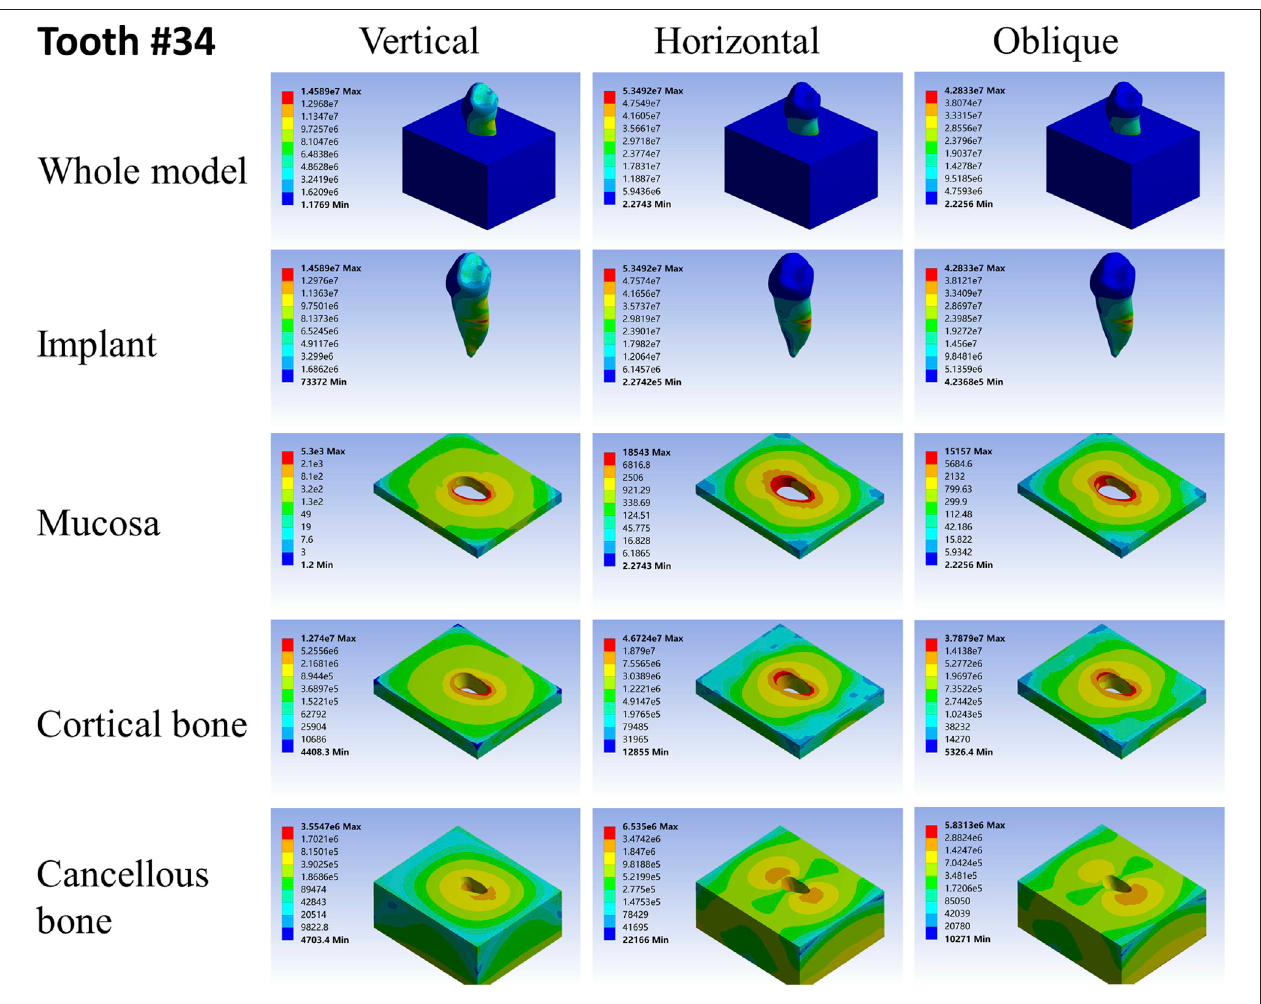
FIGURE 4 | Stress distribution of 34 under 100-N